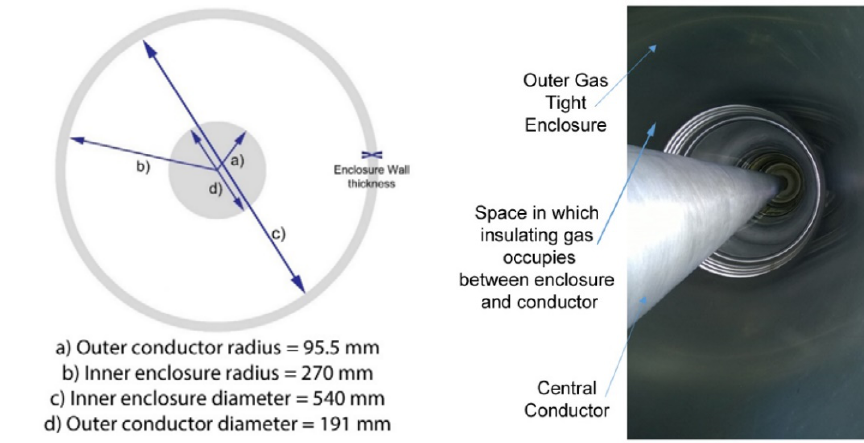
Figure 3. Gas insulated line inner conductor and outer enclosure